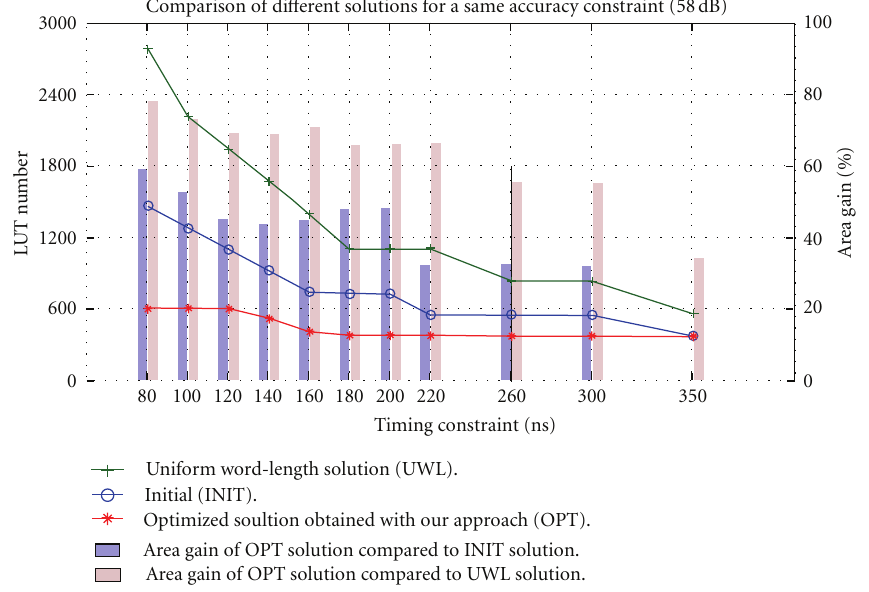
Figure 10: Comparison of the solution obtained by the proposed method (OPT) with a UWL solution and with the initial solution (INIT) for an FFT with an SQNR of 58 dB